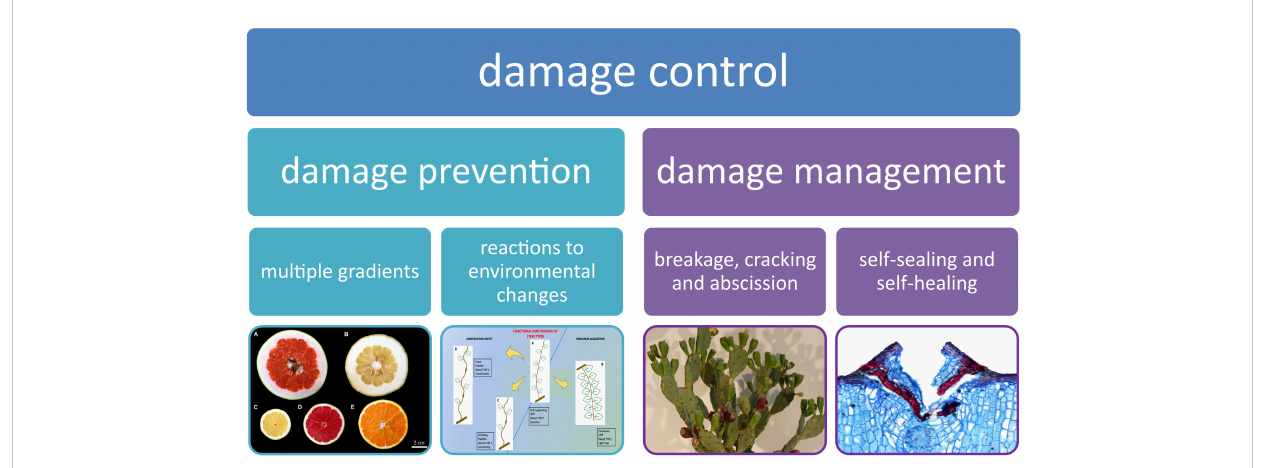
FIGURE 1 Damage control in plants can be accomplished through either damage prevention or damage management (modi fi ed from Speck et al.,